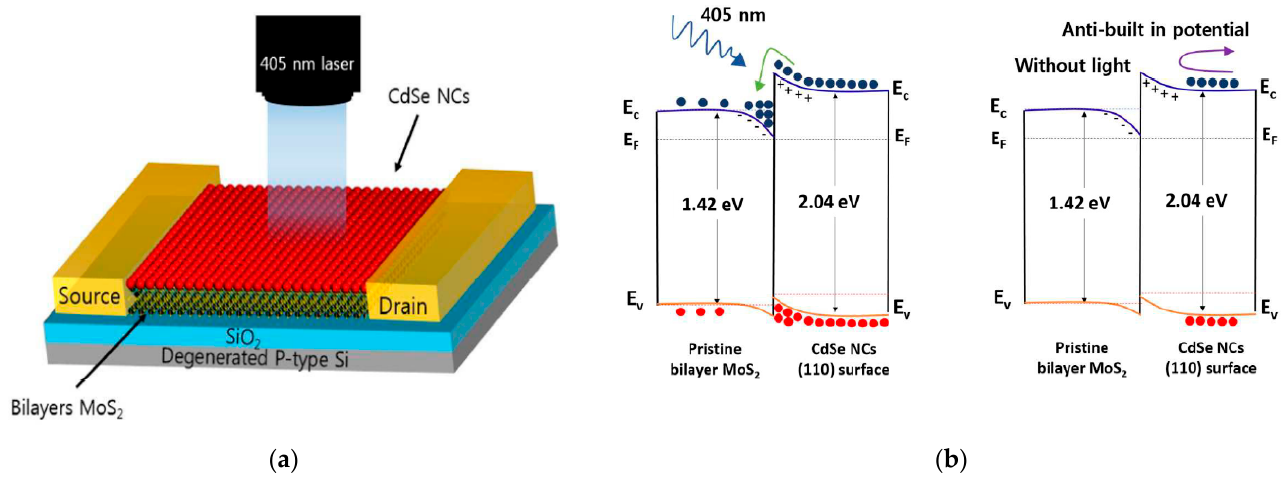
Figure 12. ( a ) Structure of a phototransistor sensitized with CdSe nanoparticles. ( b ) Band alignment between MoS 2 and CdSe nanoparticles and their carrier representation when light in ON or OFF. Reprinted with permission from ref. [34]. © 2009, Royal Society of Chemistry.